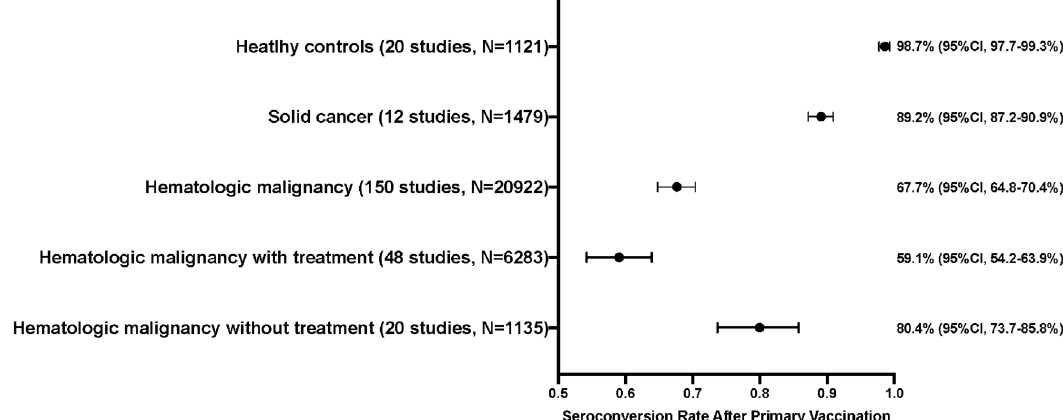
Fig. 1 Pooled seroconversion rates following complete primary SARS-CoV-2 vaccination in patients with hematologic malignancies compared to those of healthy controls and patients with solid cancers. Pooled seroconversion rates of hematologic malignancy patients with treatment and those without treatment were calculated from studies with disaggregated data on